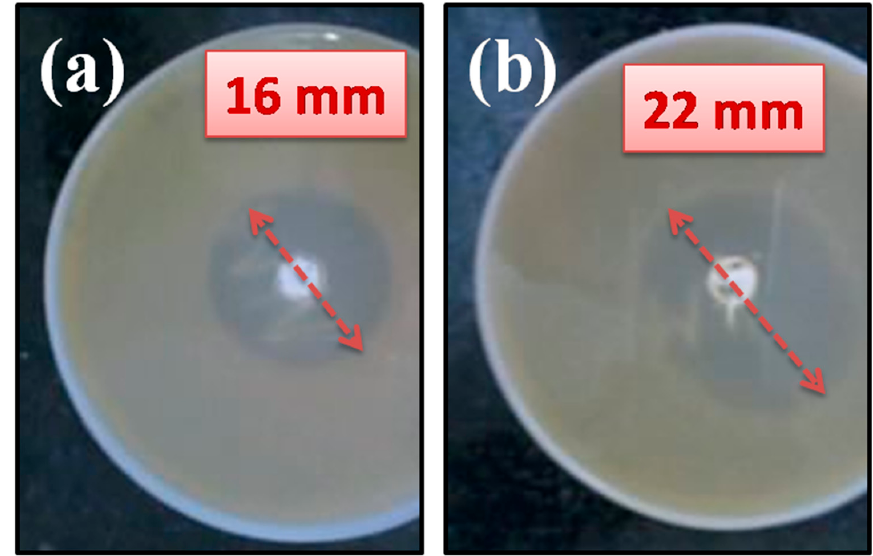
Figure 5. Zone of inhibition obtained with CeO 2 NPs for ( a ) E. coli and ( b ) S. aureus.